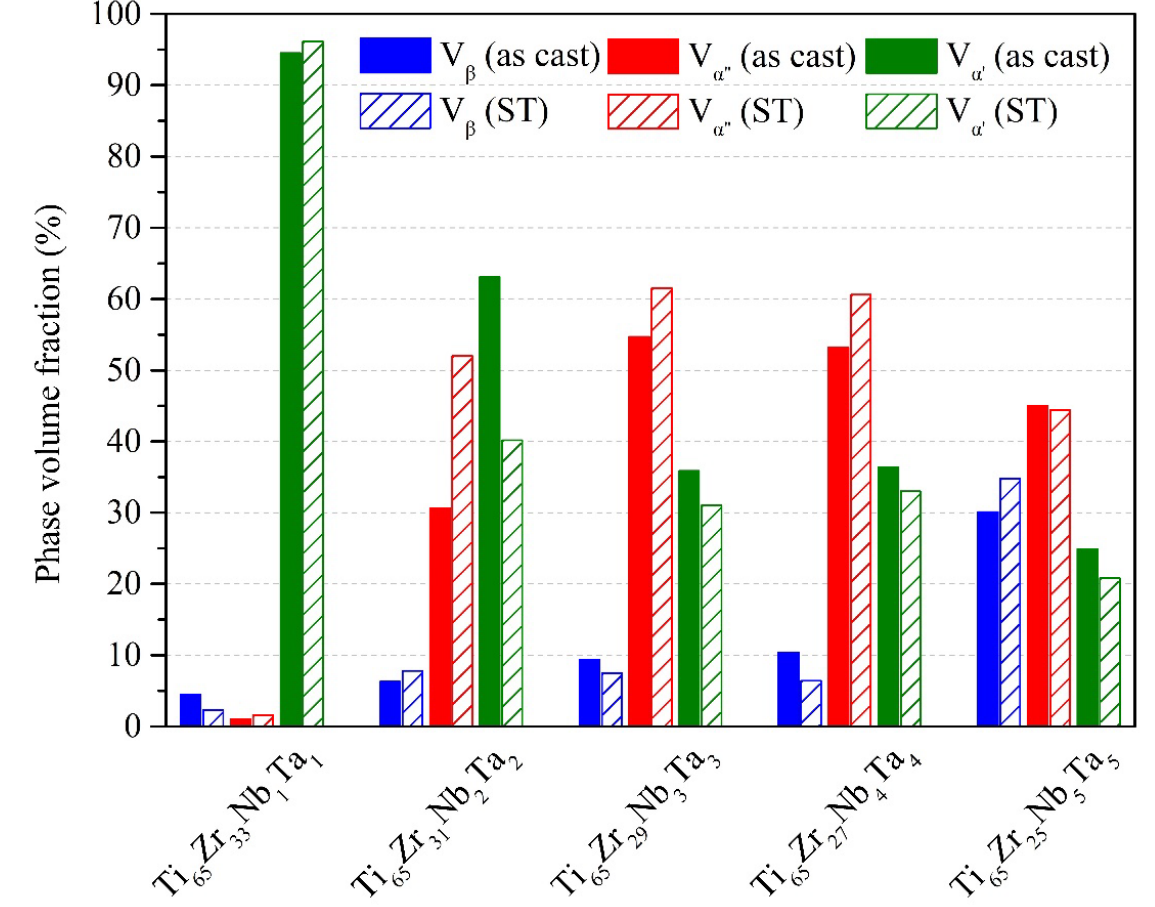
Figure 2. Phase volume fractions (%) of the Ti–Zr–Nb–Ta MEAs under various conditions.